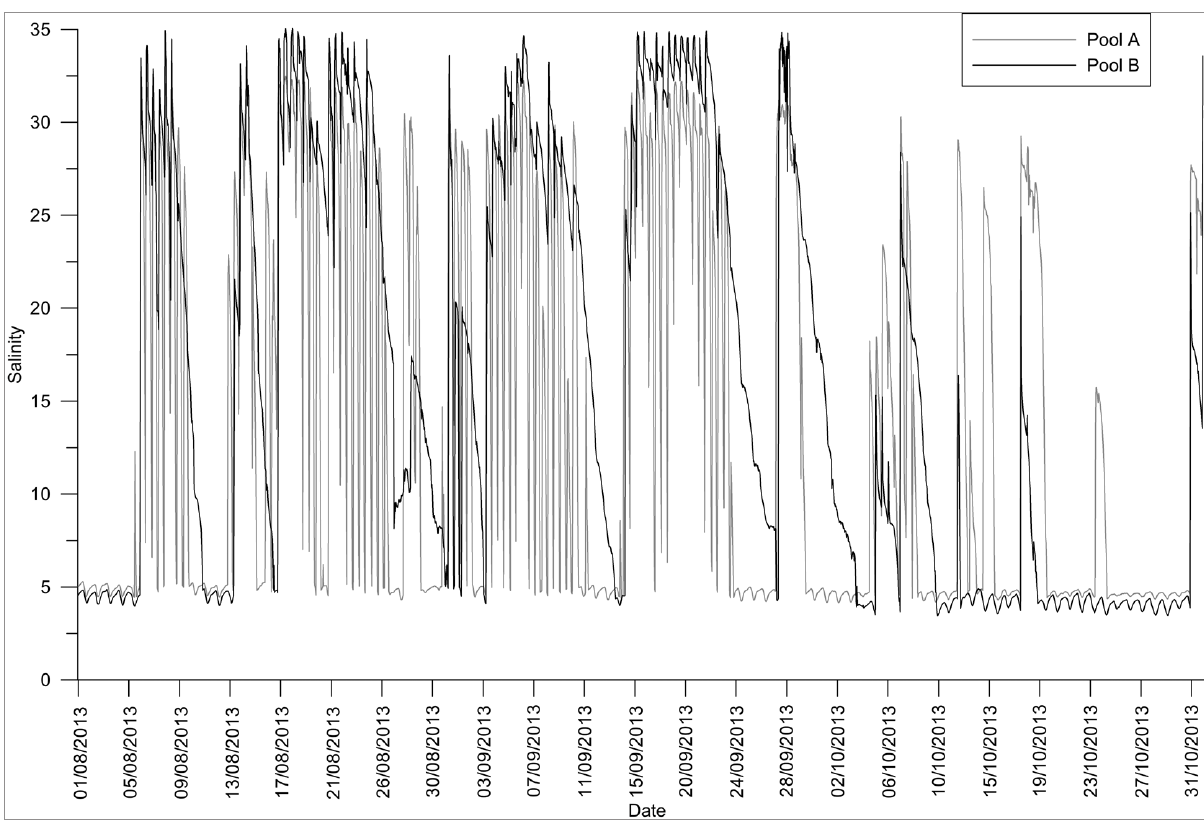
Figure 3: Hourly salinity readings from the bottom of Pools A and B from 01 August to 31 October 2013. The lower limit of the instrument is ~5.